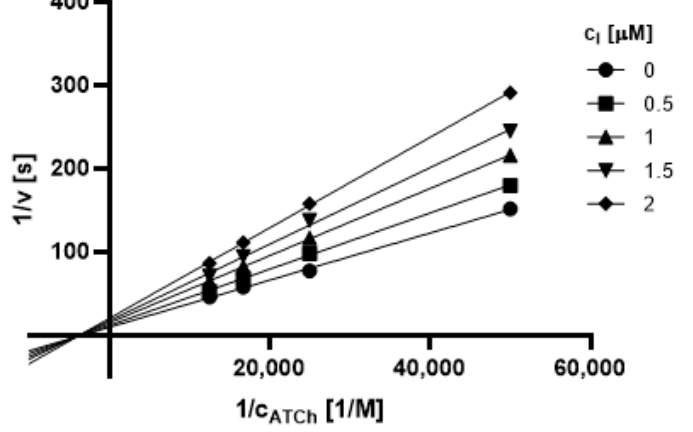
Figure 11. Lineweaver–Burk plot for 2a and AChE inhibition (ATCh = acetylthiocholine).